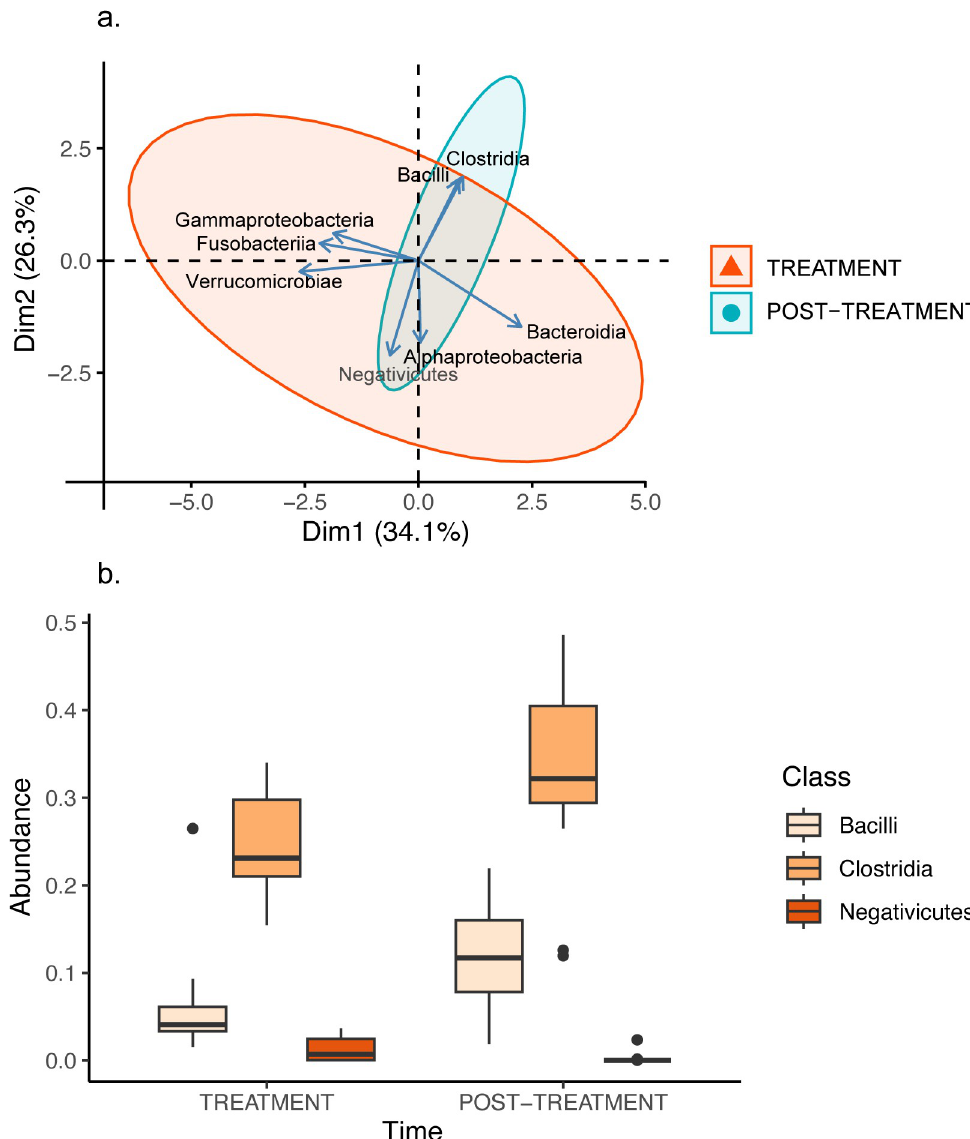
8 bacterial classes for rats treated with antibiotics (red) and more than one year later (blue). Box and whisker plot of Class Bacilli (%), Clostridia (%) and Negativicutes (%) for both